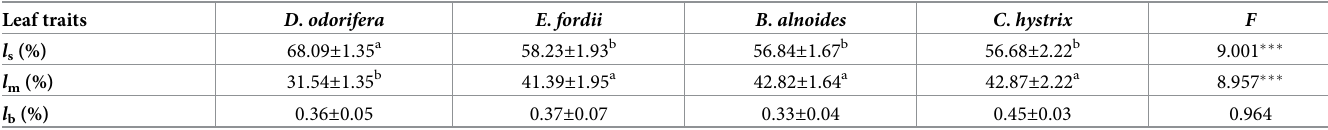
Mean values ( ± SD) were shown (n = 7).